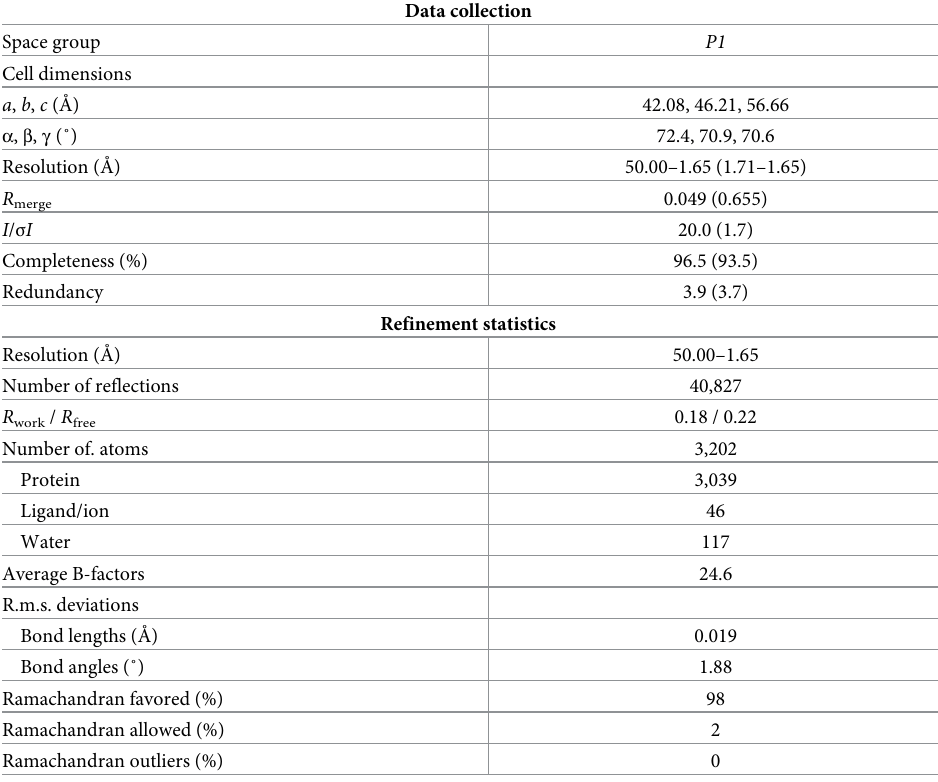
Table 2. Chz1-MC/H2A.Z-H2B data collection and refinement